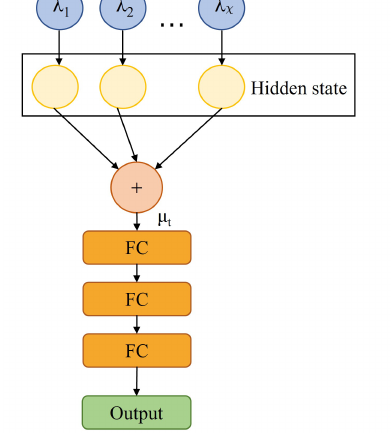
Figure 7. Structure of attention